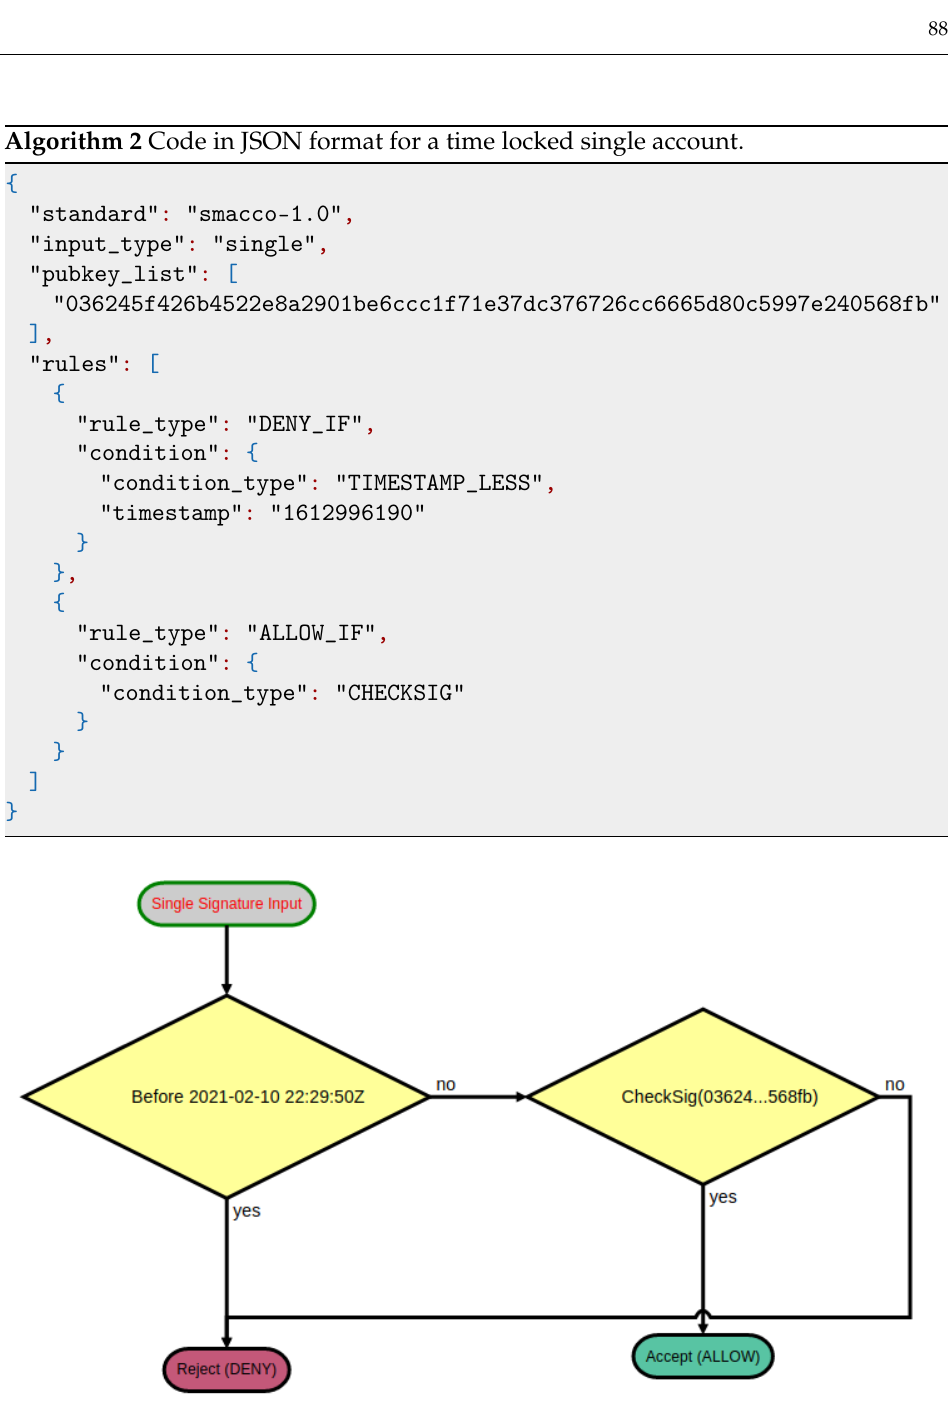
Figure 2. Flowchart of the time locked account presented in Algorithm